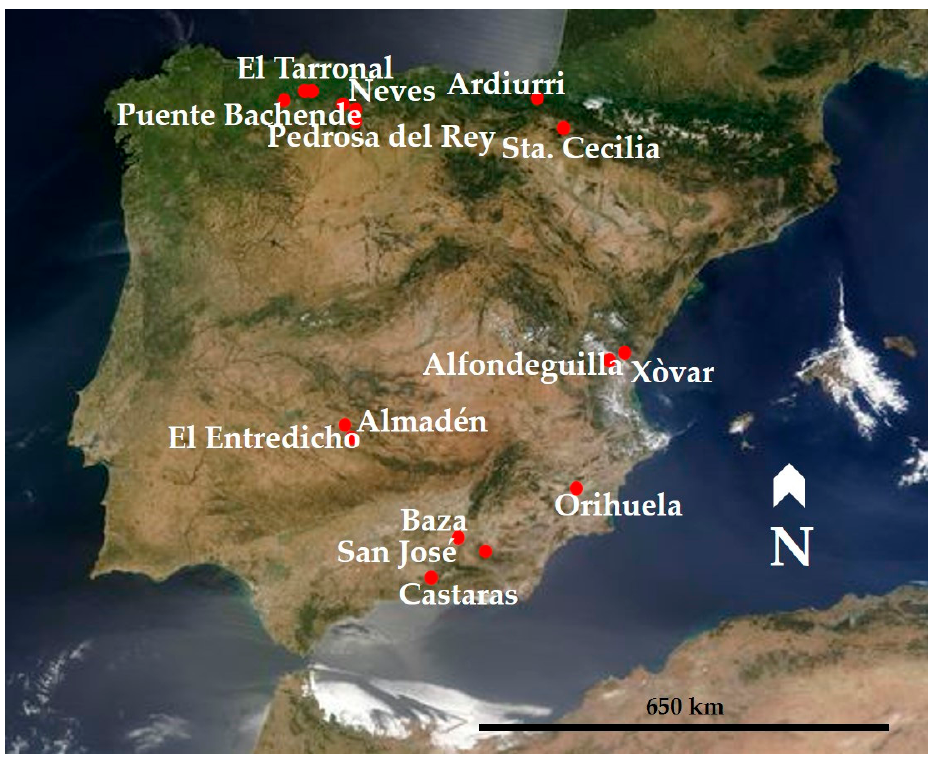
Figure 1. Map with the location of the sampled mines.